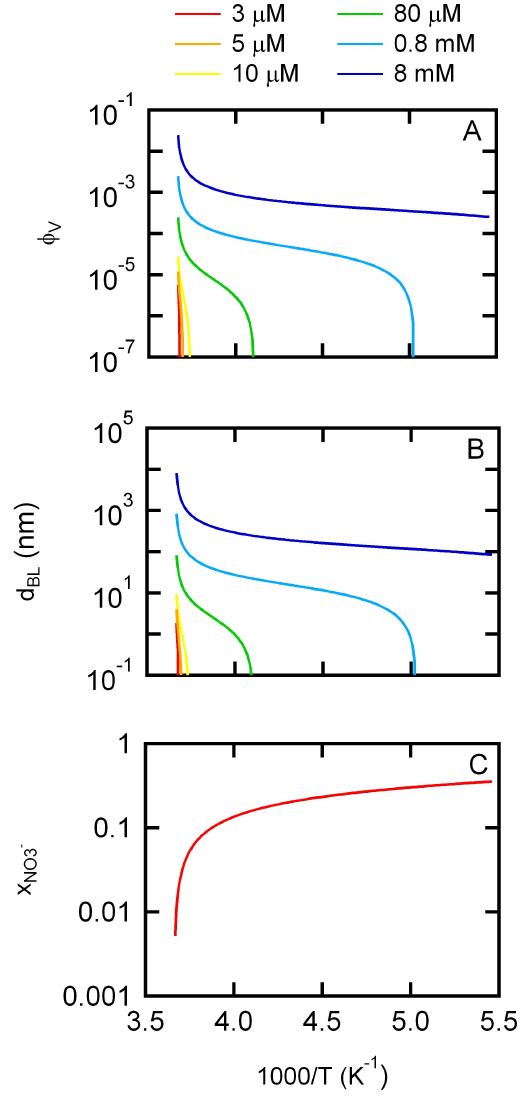
Fig. 5. Model prediction for the scenario where solute partitioning is allowed based on gas-brine and gas-ice equilibrium for (A) brine volume fraction, (B) brine thickness calculated assuming spherical ice crystals, 1mm in radius and (C) nitrate mole fraction in the brine at different nitrate concentrations in the melt and a range of temper- atures using the full model which accounts for non-ideal behavior.